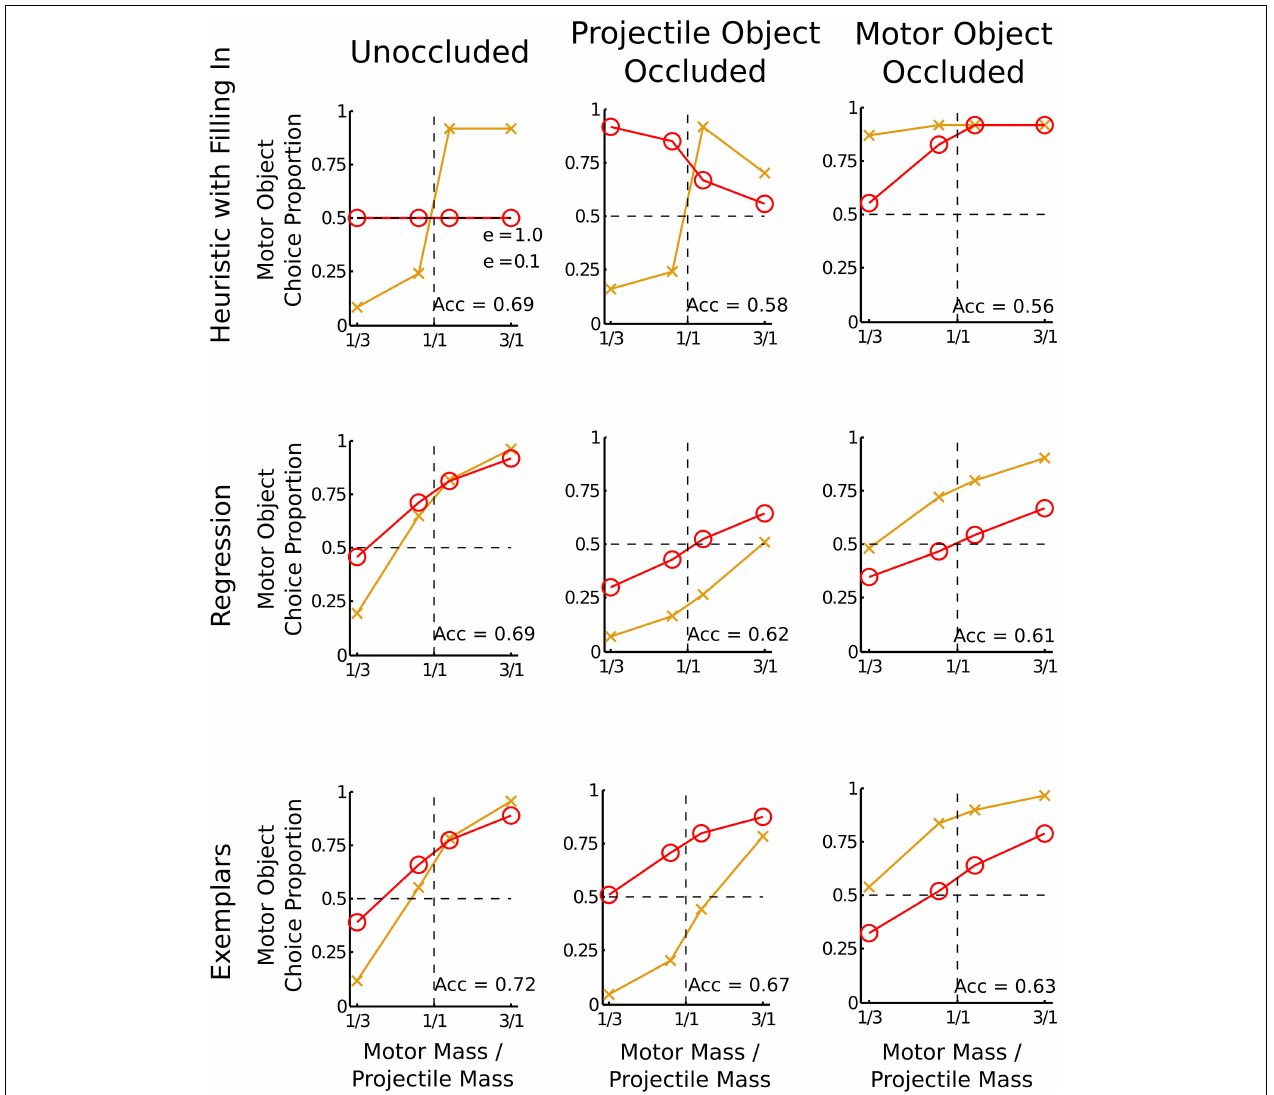
FIGURE 4 | Three alternative models for the occlusion conditions. The horizontal axis is the mass ratio of the motor object to the projectile object. The vertical axis is the proportion of trials on which participants decided the motor object was heavier. Each plot shows lines for two